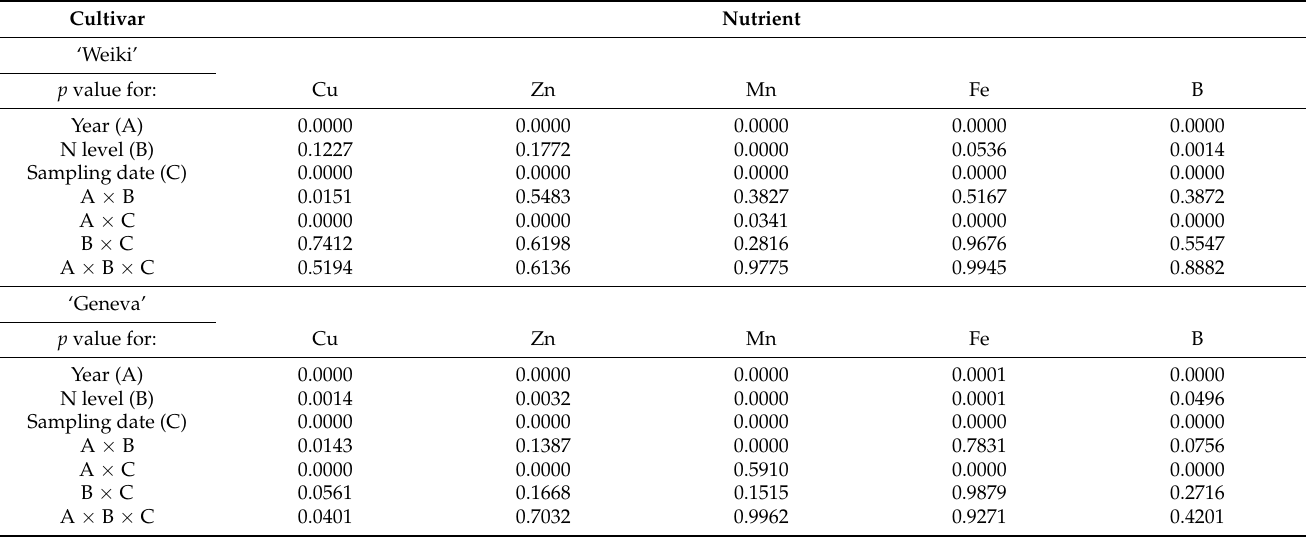
Table 2. Statistics: values of p for particular sources of variation and their interaction depending on the micronutrient and cultivar tested (LEAF tissue).